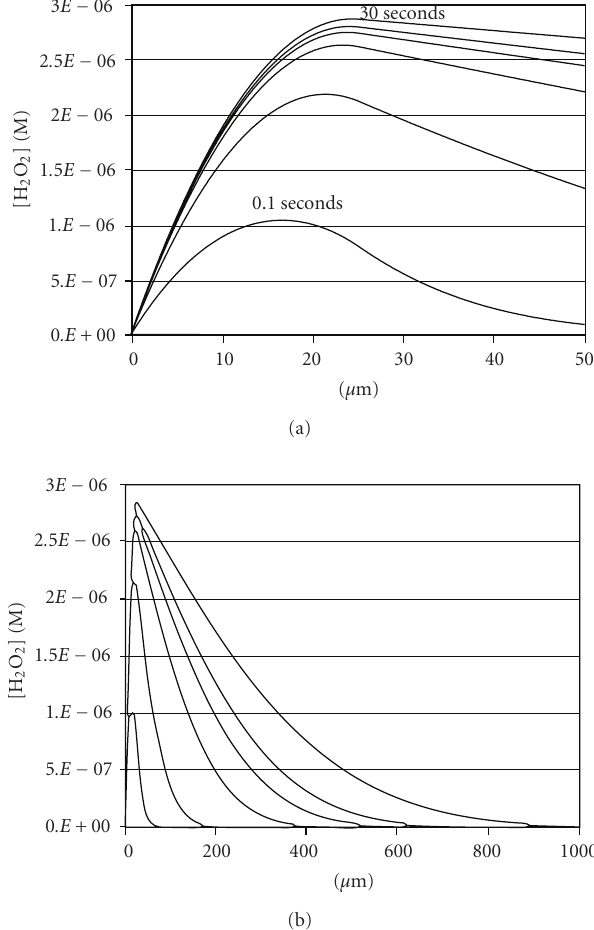
Figure 6: Simulated H 2 O 2 concentration profile with respect to exposure time (0.1, 1, 5, 10, 15, and 30 seconds) for exposure to a 2nA, 1mm diameter alpha beam with G (H 2 ) = 1 . 5, dictated by (6).